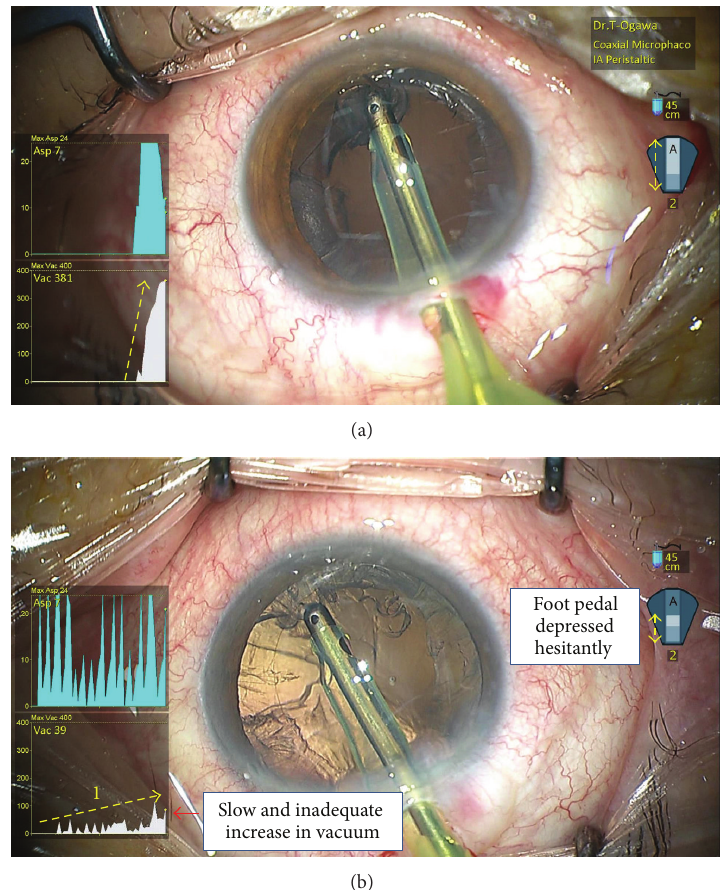
Figure 5: Aspiration of cortex. (a) Appropriate cortex aspiration technique. (b) Case 2, inappropriate cortex aspiration technique.